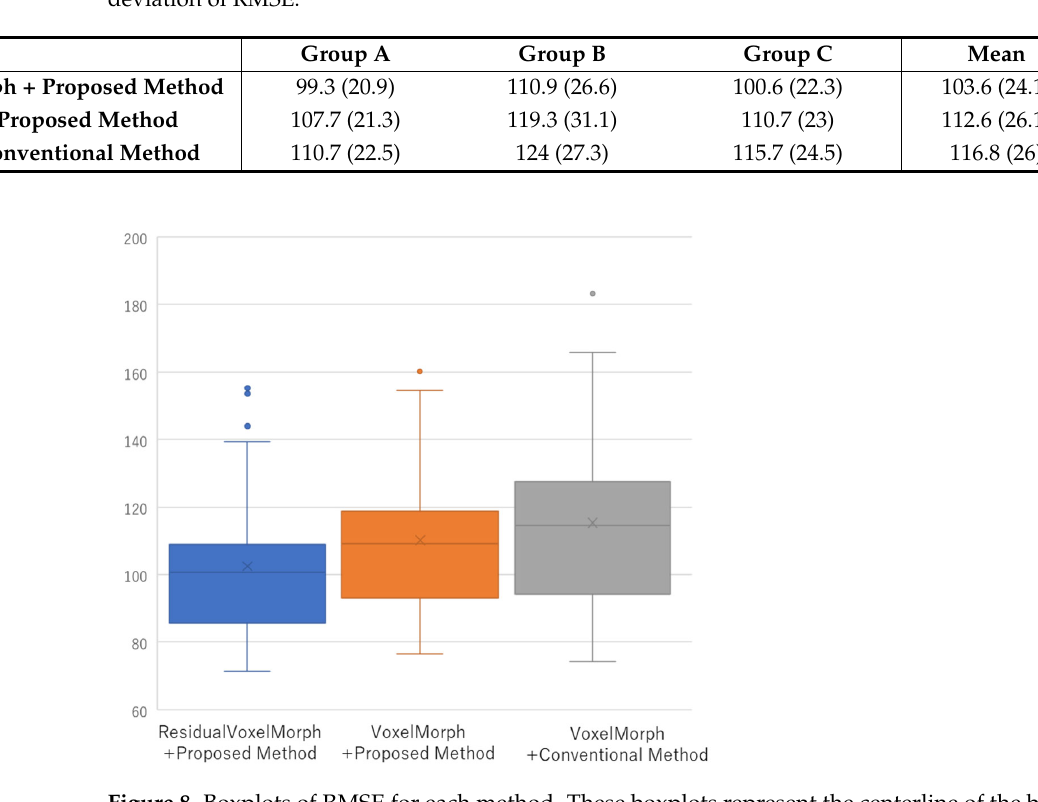
Figure 8. Boxplots of RMSE for each method. These boxplots represent the centerline of the box as the median, the top and bottom lines of the box as the 25th and 75th % tiles, the cross as the mean, and the points as the statis ‐ tical outliers. Table 4. RMSE average values in the abnormal cases of all evaluated methods. Values in parentheses represent standard deviation of RMSE.